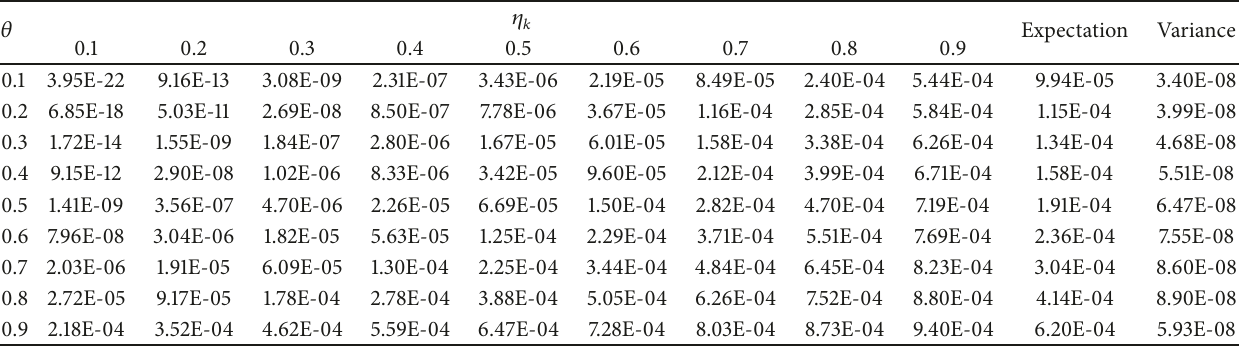
Table 4: Sensitivity analysis of the health food safety information transparency 𝜃 and the degree 𝑘 of health food consumers’ability to process 𝜃